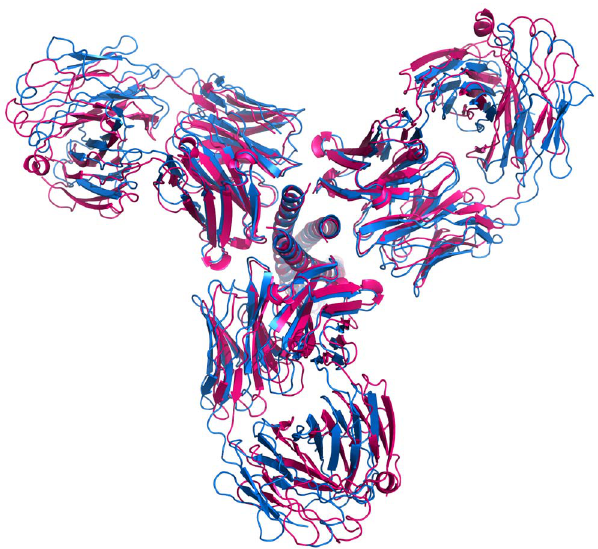
Figure 7. Overall view of the superimposed (Fab) 3 /3-H complexes. Each complex used for superposition was generated by the application of its own crystal symmetry and only the C a coordinates of the helices of 3-H were superimposed. The (Fab 8066) 3 /3-H complex is shown in red and the (Fab 8062) 3 /3-H complex in blue.